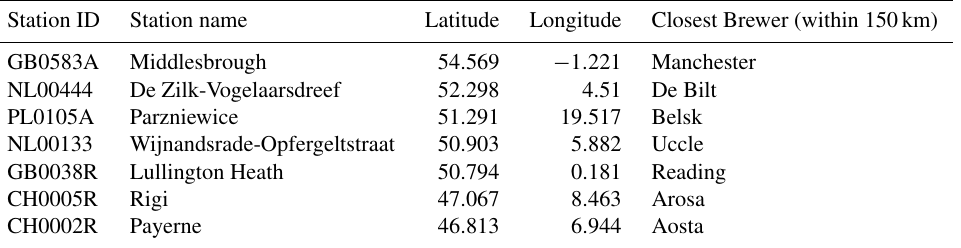
Table 3. Rural AirBase stations analysed in this study (see text). Station ID Station name Latitude Longitude Closest Brewer (within 150km) GB0583A Middlesbrough 54.569 NL00444 De Zilk-Vogelaarsdreef